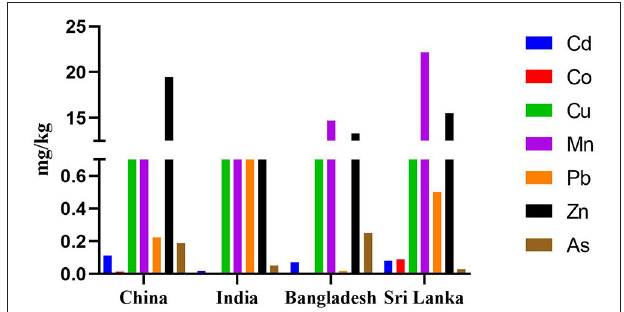
FIGURE 1 | Comparative mean heavy metal(loid)s concentrations (mg/kg) in edible part of rice reported in this study (Sri Lanka), with other studies published in China (Luo et al., 2010; Huang et al., 2013; Fan et al., 2017), India (Kumar et al., 2016), and Bangladesh (Khan et al., 2010; Rahman et al., 2014).